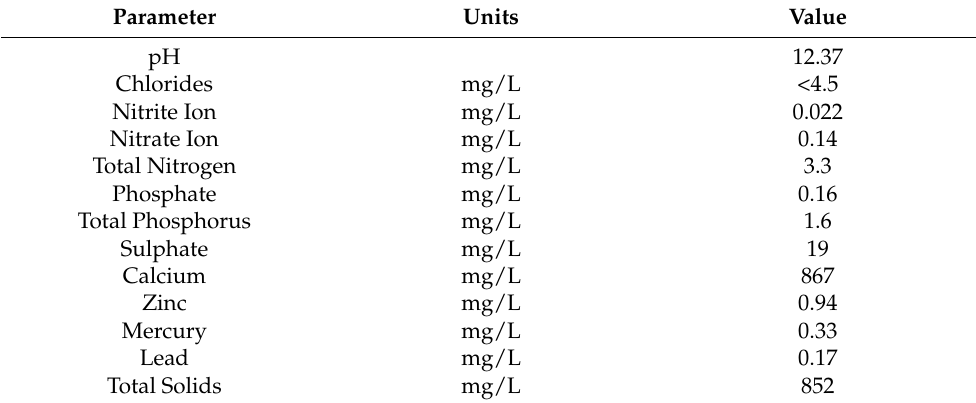
Table 2. Concrete wash water characteristics.